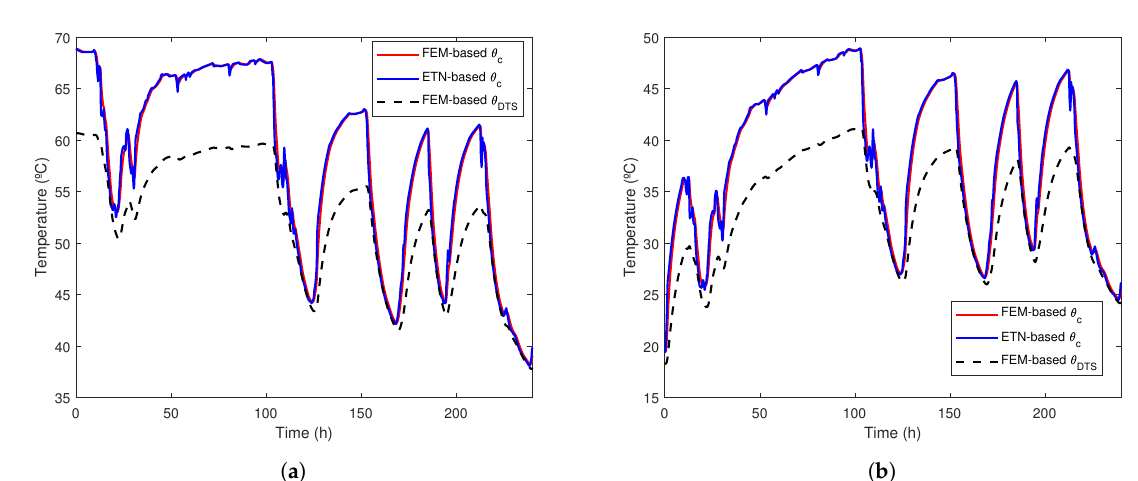
Figure 21. Estimation results for θ c in Cable 1H: ( a ) Case 1; ( b ) Case 2.